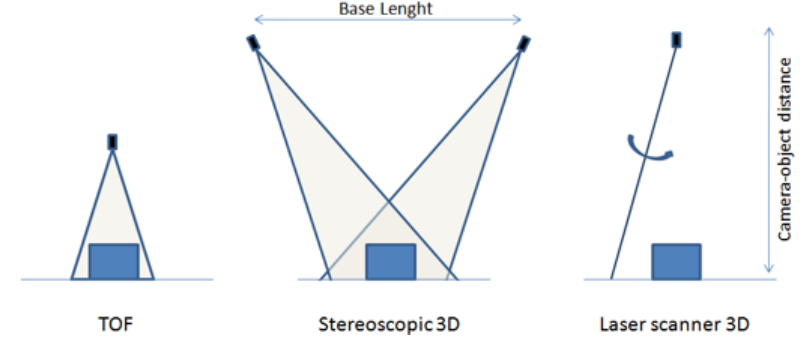
Figure 1. Different technologies for IP based measurement. Reproduced with permission from MESA